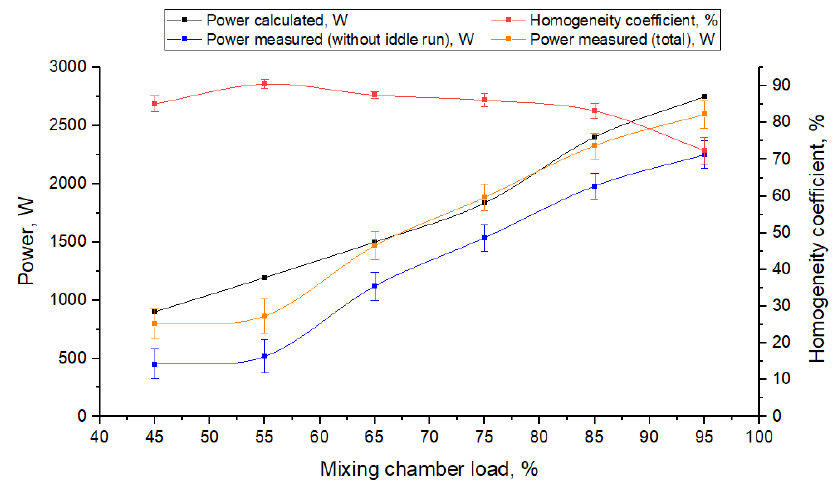
Figure 15. Mixer power consumption and mixture homogeneity coefficient in a function of the mix- ing chamber load mixing chamber